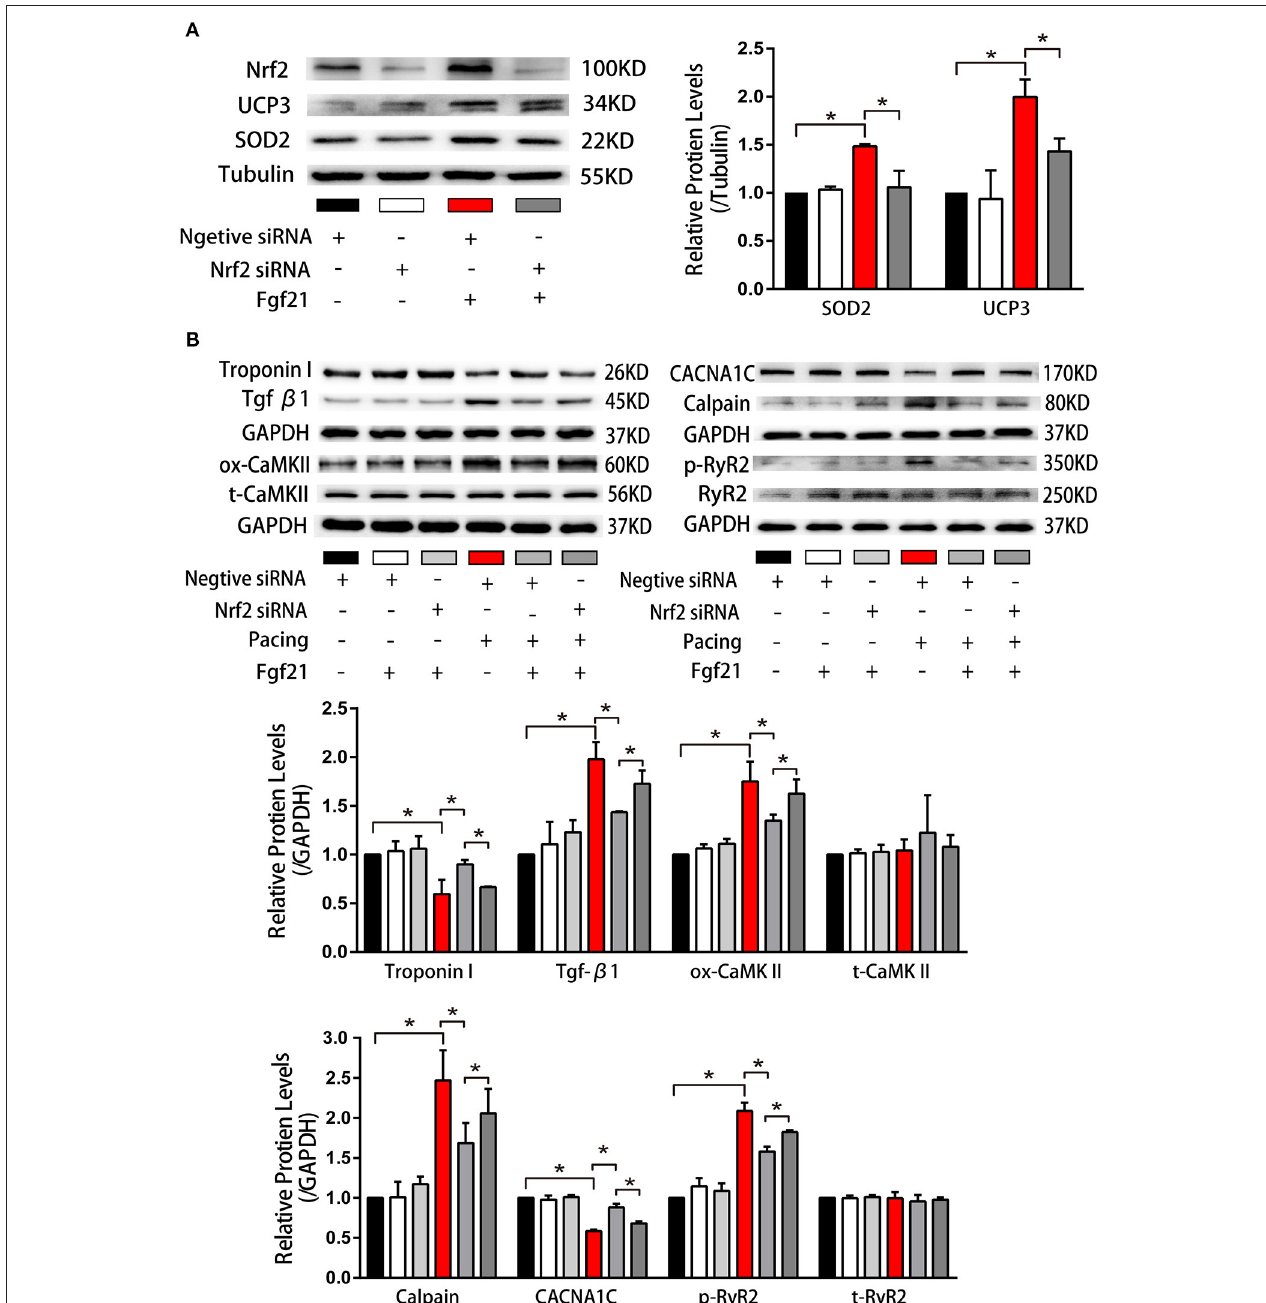
FIGURE 8 | Nuclear factor erythroid 2-related factor 2 (Nrf2) positively regulated anti-oxidative genes expression induced by Fgf21. (A) Western blot was conducted to evaluate the expression of SOD2 and UCP3 in HL-1 atrial cells by knockdown of Nrf2 with si-Nrf2. (B) Western blot was conducted to evaluate the expression of Troponin I, Tgf- β , ox-CaMKII, t-CaMKII, CACNA1C, Calpain, p-RyR2, and t-RyR2 in HL-1 atrial cells by knockdown of Nrf2 with si-Nrf2. * p <